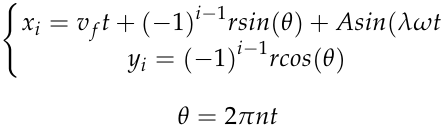
Figure 4. Schematic diagram of tool tip path.